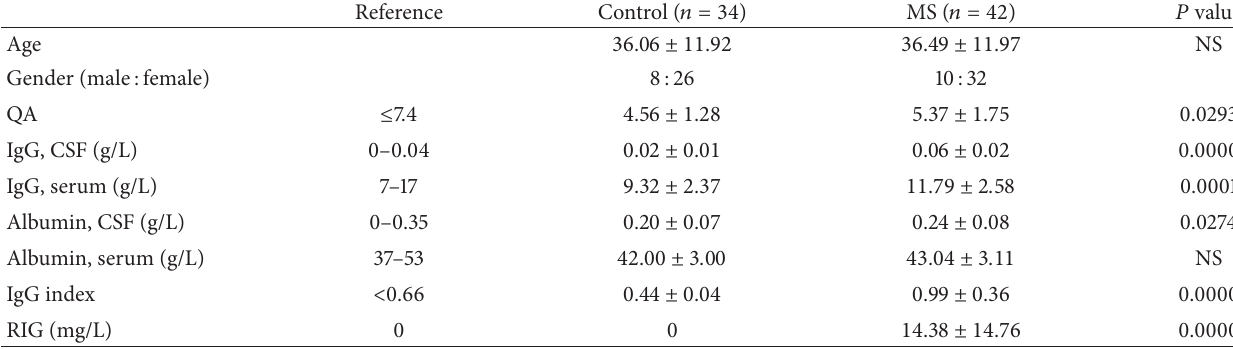
Table 1: Levels of selected biochemical parameters in patients with multiple sclerosis (MS) and the neurological control group.